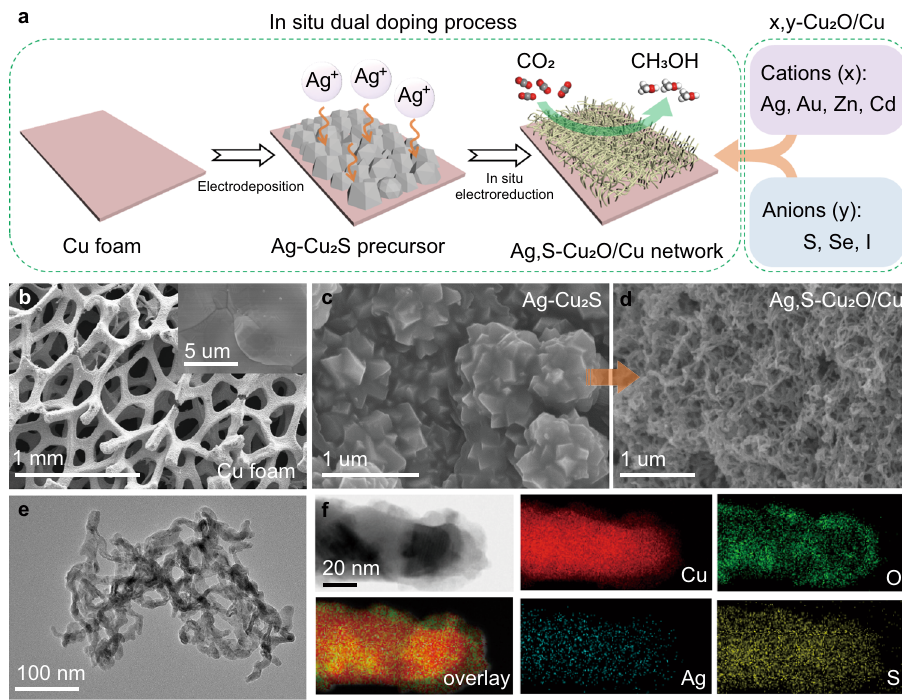
Fig. 1 Synthesis and structure characterizations of x,y-Cu 2 O/Cu. a Schematic diagram of the in situ dual-doping process for preparing the x,y-Cu 2 O/Cu catalysts. SEM images of b bare Cu foam substrate, c Ag-Cu 2 S precursor on Cu foam substrate, and d Ag,S-Cu 2 O/Cu formed at electroreduction time of 30 min. e TEM image of the Ag,S-Cu 2 O/Cu. f Scanning transmission electron microscopy (STEM) and elemental mapping of a typical Ag,S-Cu 2